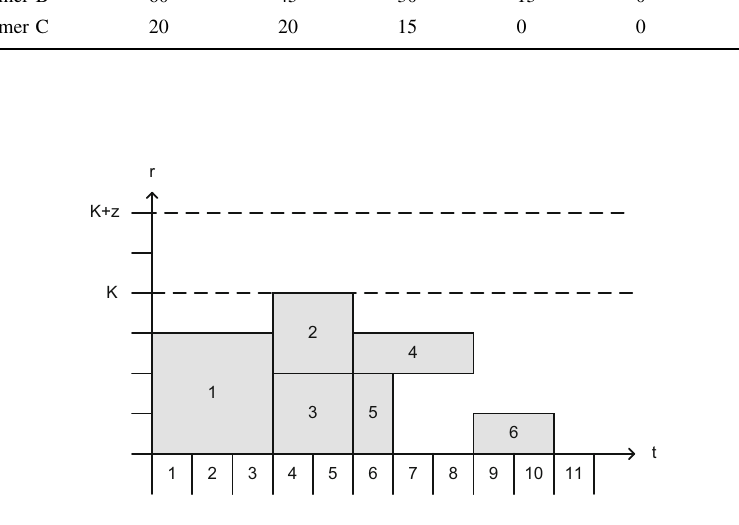
Fig. 2 Optimal schedule without overtime usage for customer